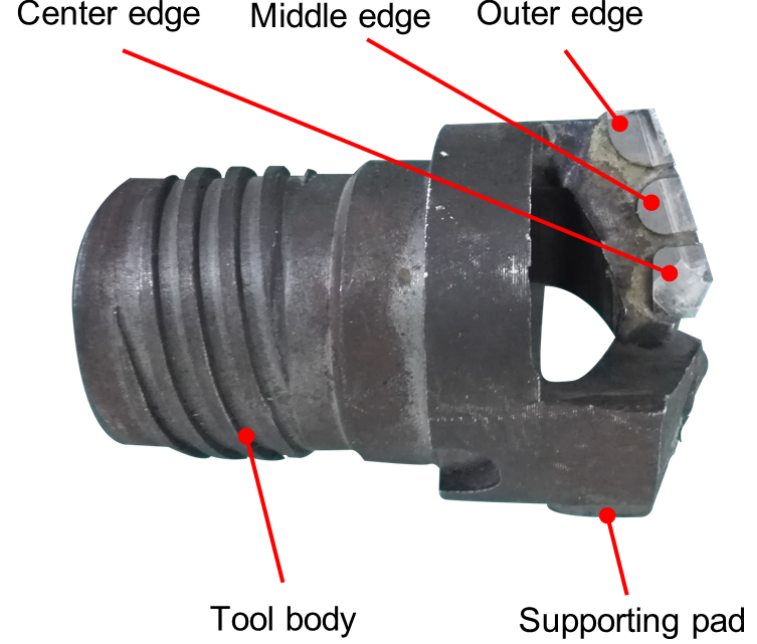
Figure 3. Structure of the cutting